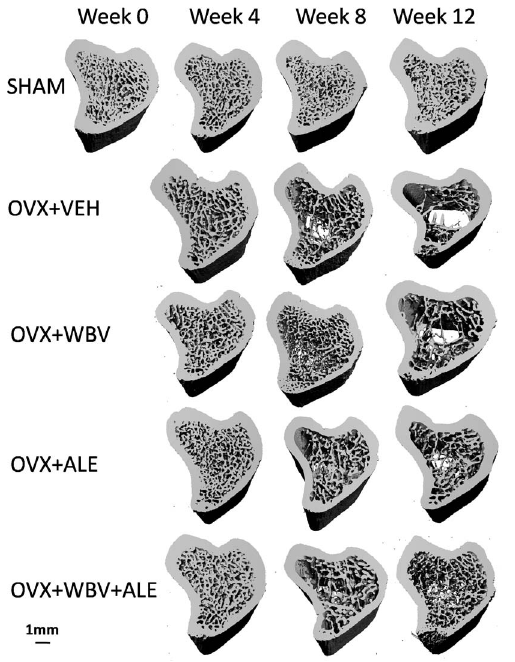
Figure 4. Three-dimensional m CT images of the metaphyseal tibia of the SHAM, OVX + VEH, OVX + WBV, OVX + ALE, and OVX + WBV + ALE-treated Sprague Dawley rats at the time of operation and follow-up measurements after four, eight and 12 weeks. Images were selected from animals with median cancellous BV/TV values.